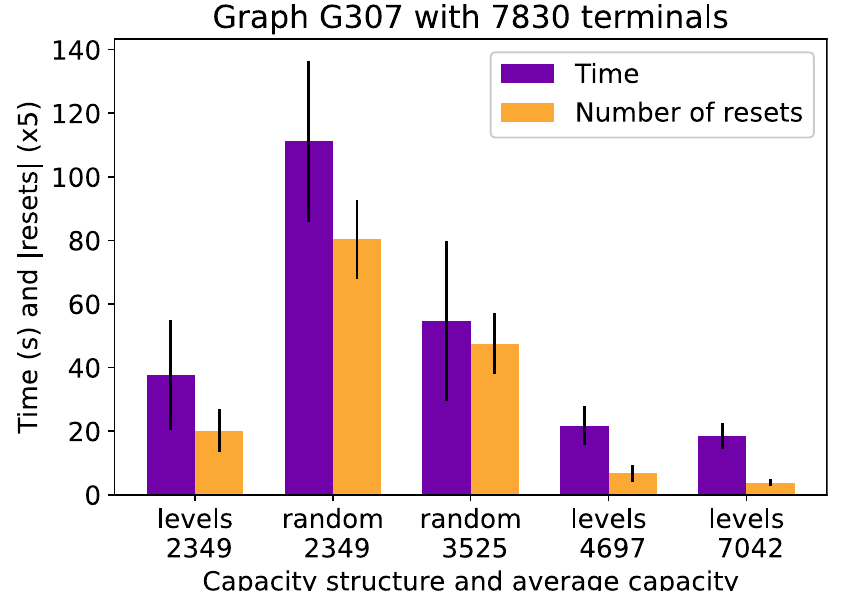
Fig 10. Vienna G307 time compared by capacity. The time (purple bars) and number of resets (yellow bars) for 5 different capacity settings for the G307 graph.